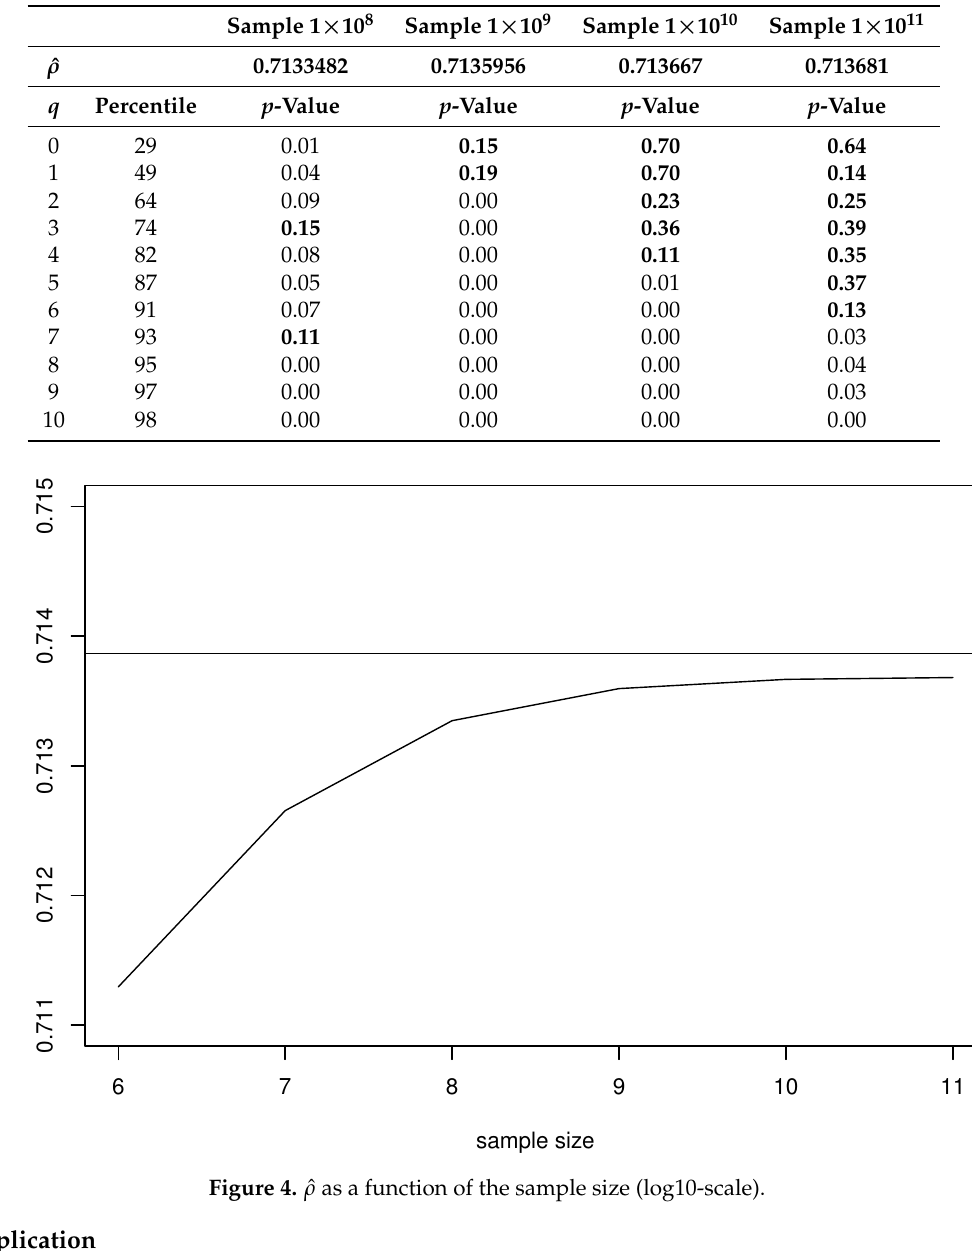
Table 2. Pearson’s χ 2 tests for goodness of fit with a geometric distribution.